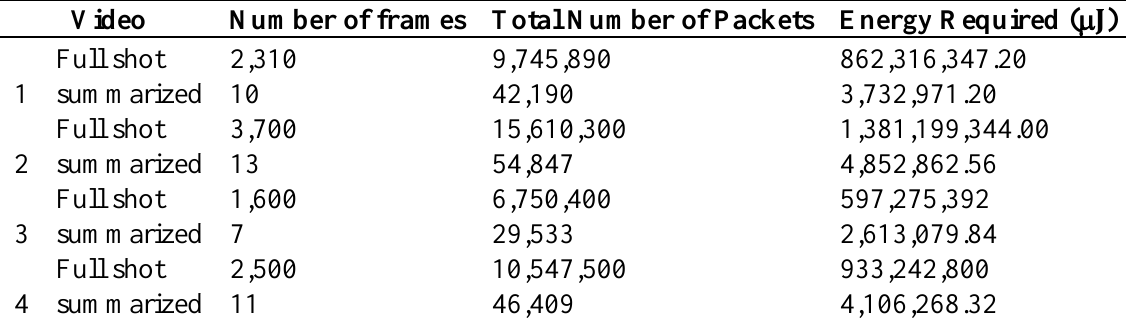
Table 5. Transmission energy analysis for four